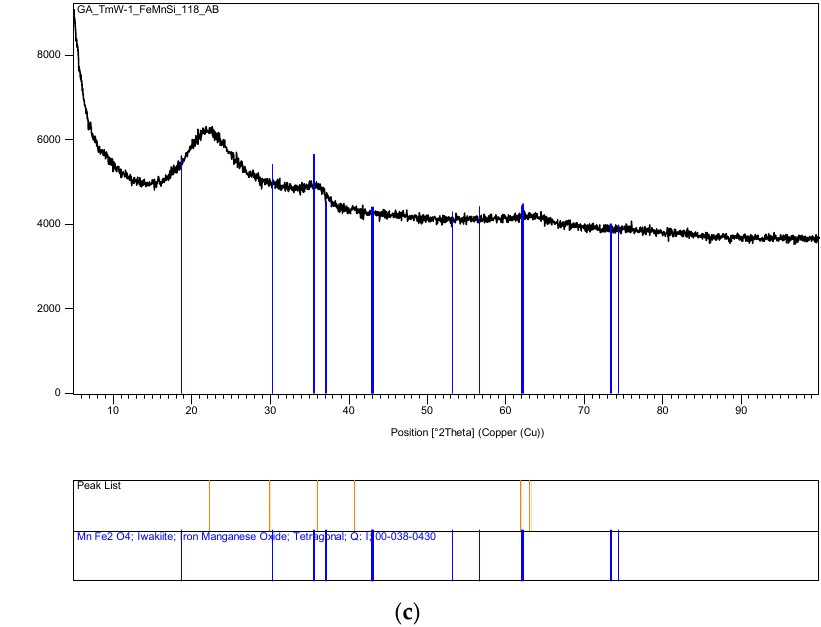
Figure 15. XRD patterns of iron based silica supported catalyst systems obtained from 120 h of UV ‐ radiation at LUX = 82,000 lx, 25 °C and 50% relative humidity using an agricultural growth cabinet ( a , b ) or under combined microwave and thermal treatment ( c ). Glass beakers (50 mL capacity) were used to contain 20 mL supported catalyst precursor fluid to obtain flakes of the supported catalyst.